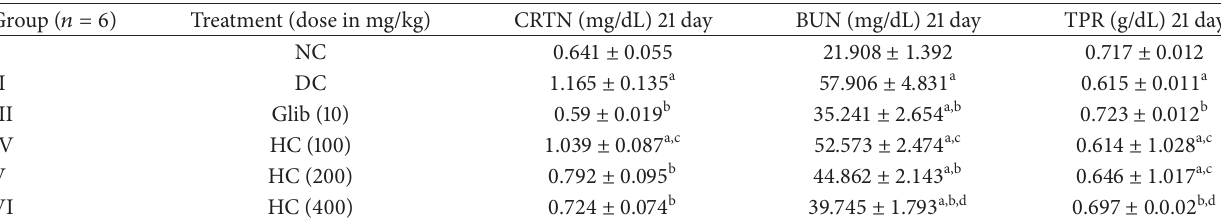
Table 3: Effect of HC on other biochemical parameters.